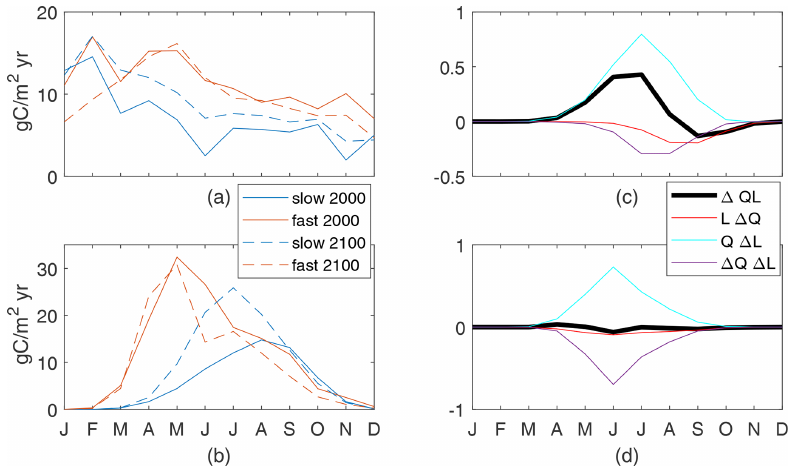
Figure 10. Arctic nutrient supply (a) and production (b) . Production controls on the slow (c) and fast (d) cases, normalized by the maximum values of arctic maxQL(2000): 0.021 for the slow case and 0.028 for the fast case.